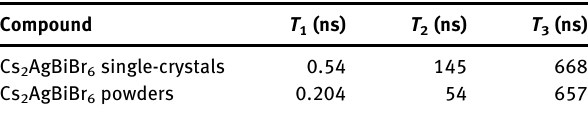
Table  : Full fi t of the TRPL data for Cs  AgBiBr  single-crystal and powder samples [ 